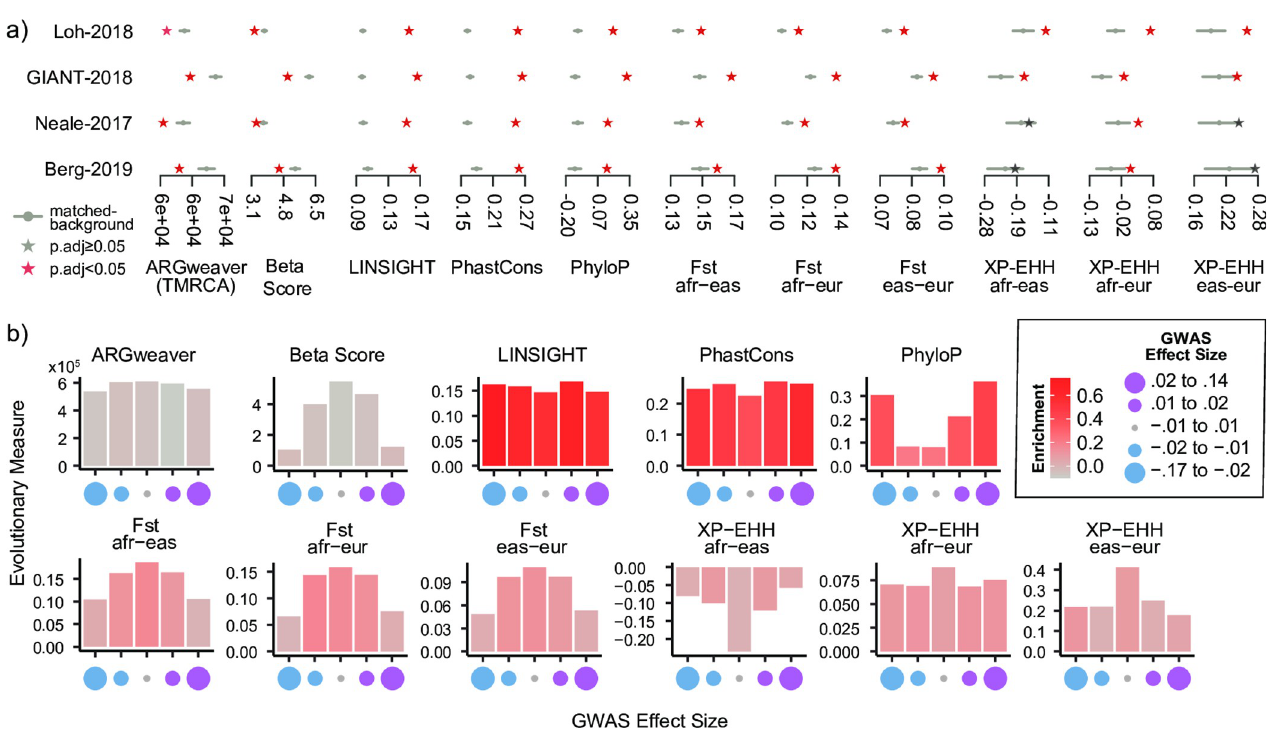
Fig 2. The enrichment for evolutionary signatures is consistent across multiple GWASs of the same trait. (a) For four separate GWASs of height (y-axis), we compared the mean trait-associated values (stars) for multiple evolutionary measures (x-axis) with their corresponding matched genomic background mean values (gray dot: mean value, gray bar: 5th, 95th percentile). We calculated an empirical p-value by comparing to the matched background (Methods) and adjusted for multiple testing (FDR-adjusted p-values < 0.05 are denoted as red stars, Methods). (b) For the Loh-2018 GWAS, we partitioned the trait- associated regions based on the association effect size (Beta Coefficient) of the lead SNP into five bins with equal numbers of trait-associated regions (x-axis). Each plot represents the mean value (y-axis) for a specific evolutionary measure. Bars are colored by their evolutionary enrichment values, which were calculated as described in Fig 1D. See Table 2 and Methods for details on the four GWASs analyzed.